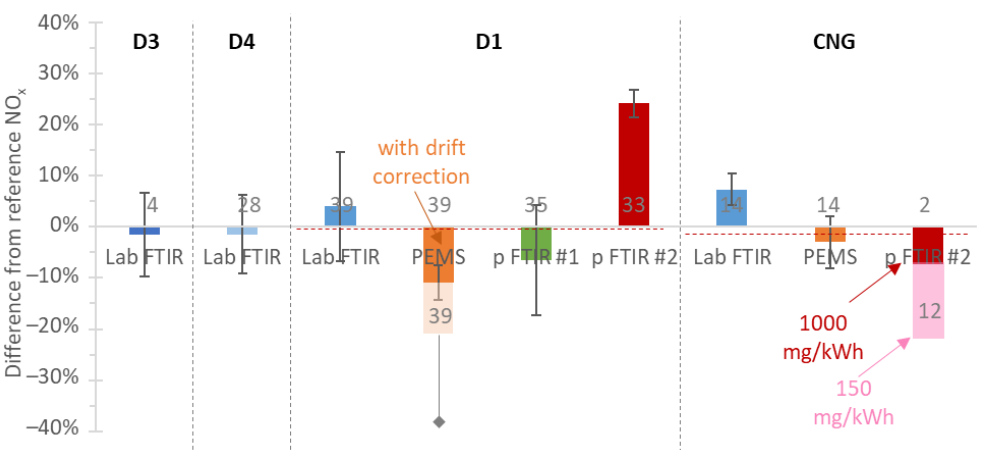
Figure 5. Comparisons of instruments measuring NO x vs. laboratory CLD analyzers. Red dashed lines give the means of all the instrument measurements. Error bars are one standard deviation of the number of repetitions given in/on the bars. CLD = chemiluminescence detection; CNG = compressed natural gas engine; D = diesel engine; FTIR = Fourier transform infrared; p = portable; PEMS = portable emissions measurement system (with CLD analyzer).